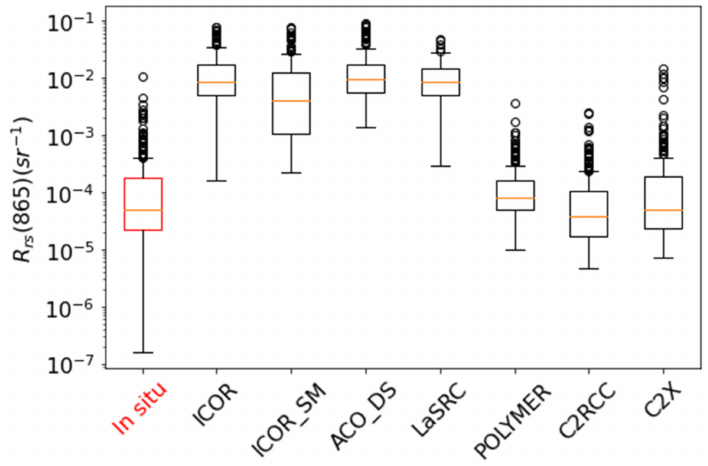
Figure 9. Comparison of the distributions of the in situ measured R rs and R rs retrieved by each processor in the NIR band (865 nm) of OLI (Landsat 8). The median values are shown as the green lines, and the circles represent the outliers.